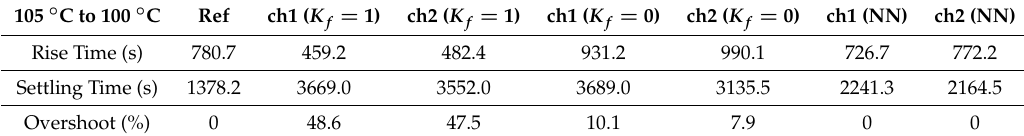
Table 2. Comparison of simulation results for time response characteristics (105 ◦ C to 100 ◦ C).